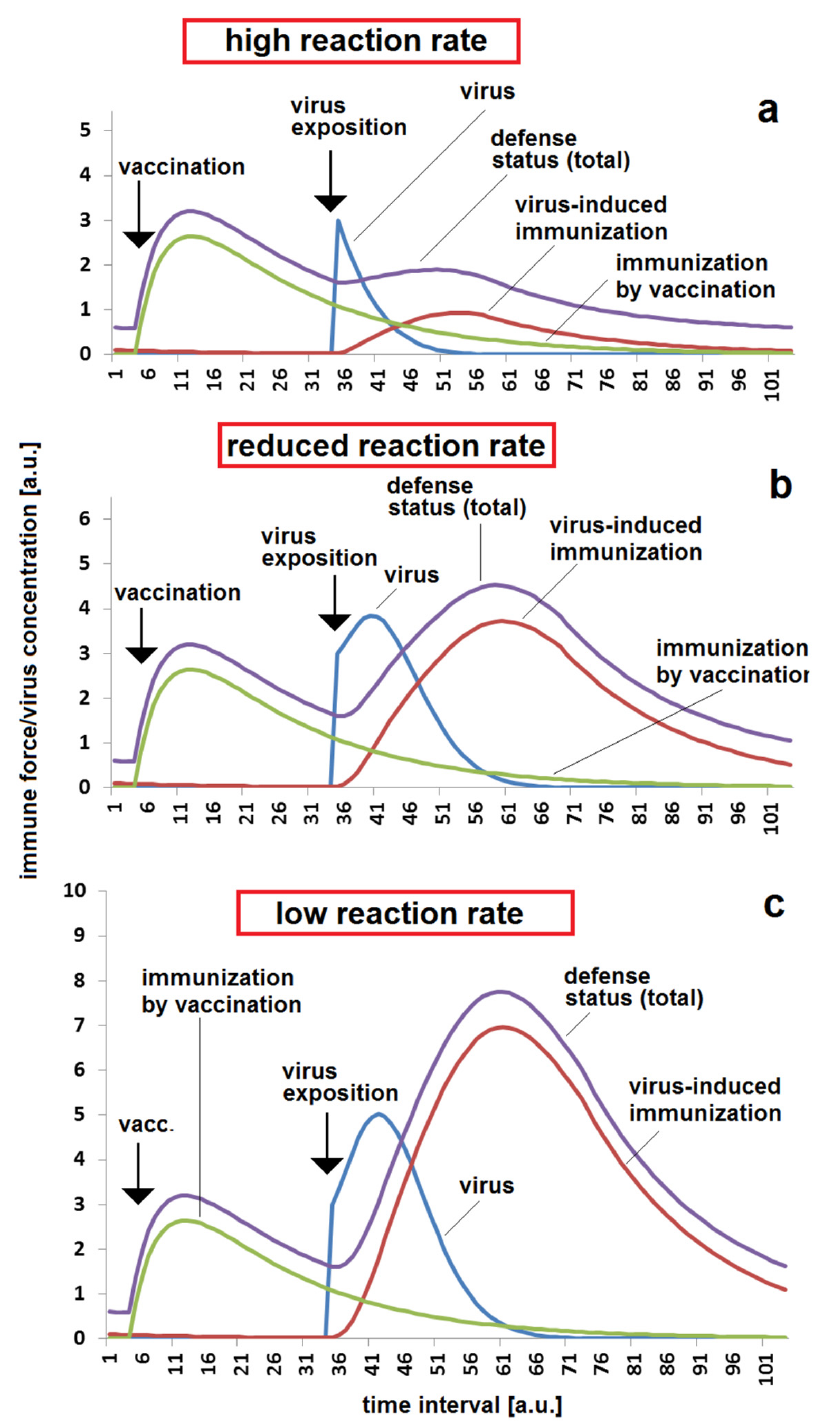
Figure 2. Immunization status, reaction and re-activation by infection with respect to reaction rate in case of a moderate time span between vaccination and virus exposition: ( a ) low immune response in the case of a high reaction rate k r = 0.2; ( b ) enhanced response in the case of a moderate reaction rate, k r = 0.06; ( c ) high response to virus exposition and strong additional immune response in the case of a low reaction rate, k r = 0.03. The set of other parameters for all three simulations ( a – c ): k vir = 0.3; k st = 0.12; D vacc = 0.05; D AB = 0.05; c BGim = 0.5; v oo = 30; st oo = 10.